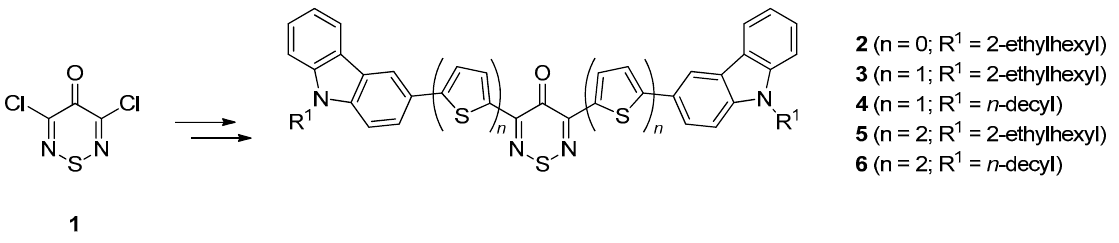
Figure 1. Examples of 1,2,6-Thiadiazine-containing oligomers studied as donors in bulk heterojunction (BHJ) organic photovoltaics (OPVs) [16].